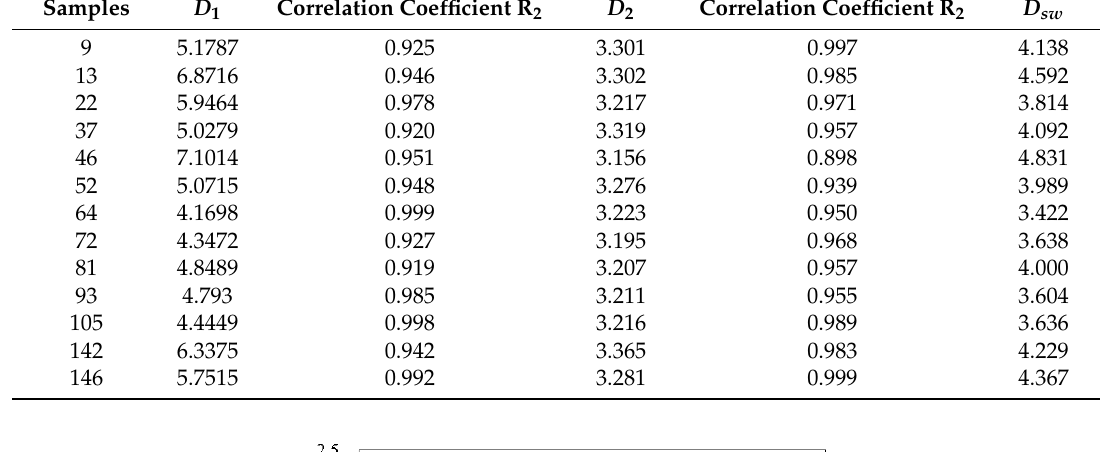
Table 2. Parameters of the fractal dimension obtained from the 13 samples.